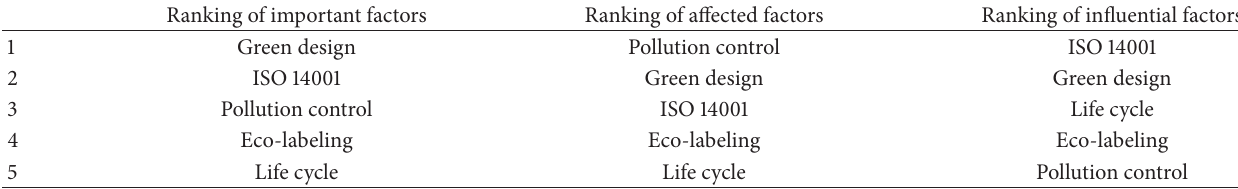
Table 7: Ranking dimensions of environmental protection.